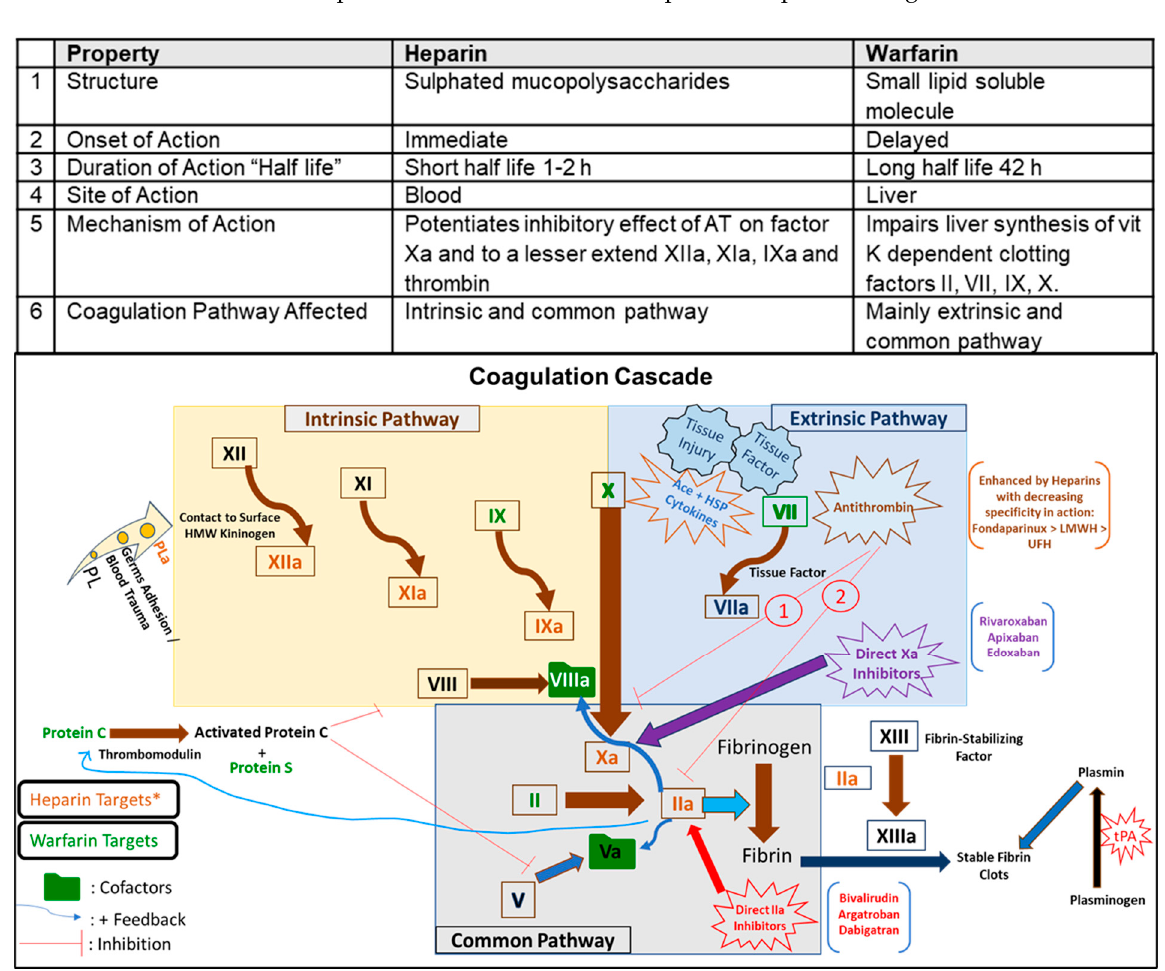
Figure 2. Blood coagulation pathways and comparison of the mechanisms of the anticoagulant activity of heparin and warfarin. vitK: Vitamin K; PL: Platelets; tPA: tissue Plasminogen activator; HMW: High Molecular Weight; PL: Phospho- lipid; PLa: activated Phospholipid; HSP: Heparan Sulphate Polysaccharides; LMWH: Low molecular weight heparin; UFH: Unfractionated heparin, “a” next to the names: activated form, AT: Antithrombin.